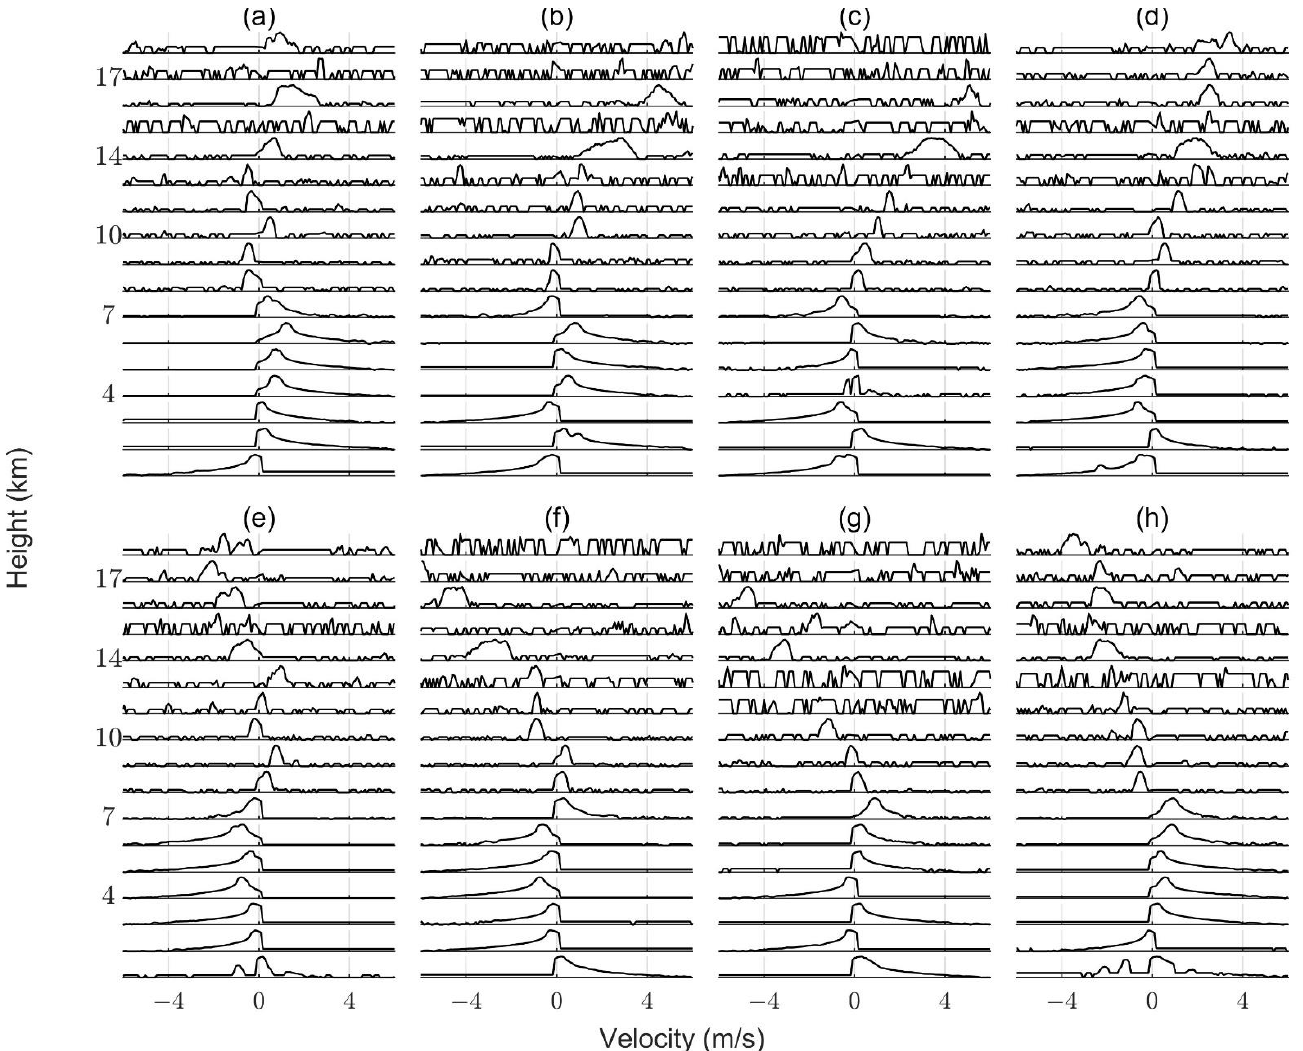
Figure 3. Derived Doppler velocity for the selected heights corresponding to Figure 2. (( a ) north), 45° (( b ) northeast), 90° (( c ) east), 135° (( d ) southeast), 180° (( e ) south), 225° (( f ) southwest), 270° (( g ) west), and 315° (( h ) northwest) with a zenith angle of 15°. The unit is m/s, and the experiment time was 10:00 local time on 17 July 2021.